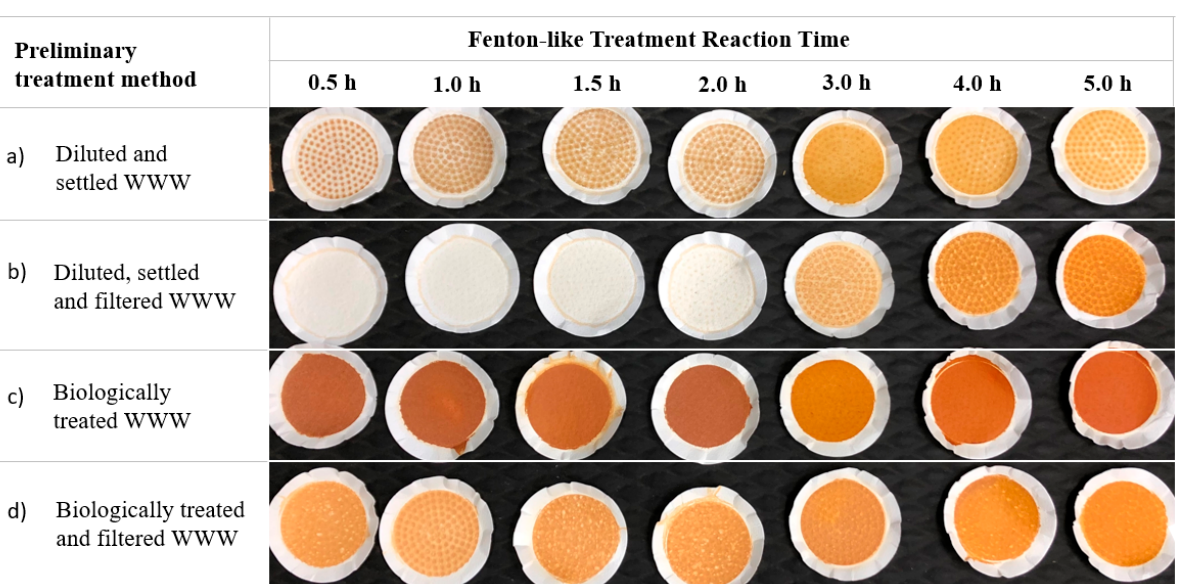
Figure 6. Evolution of COD concentrations during the Fenton-like treatment at H 2 O 2 2500 mg/L and Fe 3+ 325 mg/L of filtered and unfiltered WWW that had undergone first stage pre-treatment via settling and dilution or aerobic biological treatment.